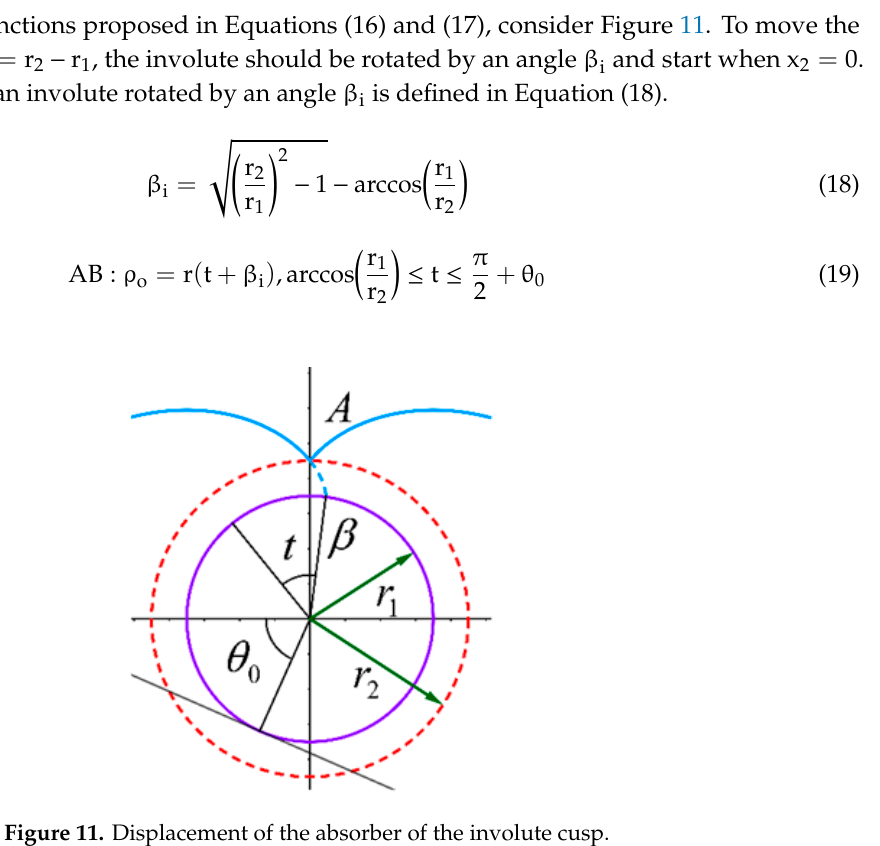
Figure 4. Main geometrical parameters of the FRESDEMO prototype [24].